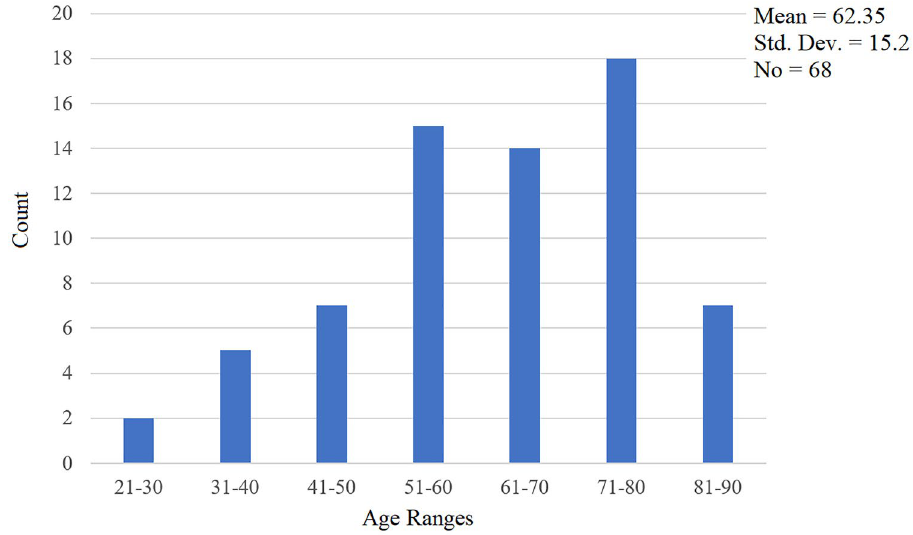
Figure 2. Age groups in 68 patients in decades.